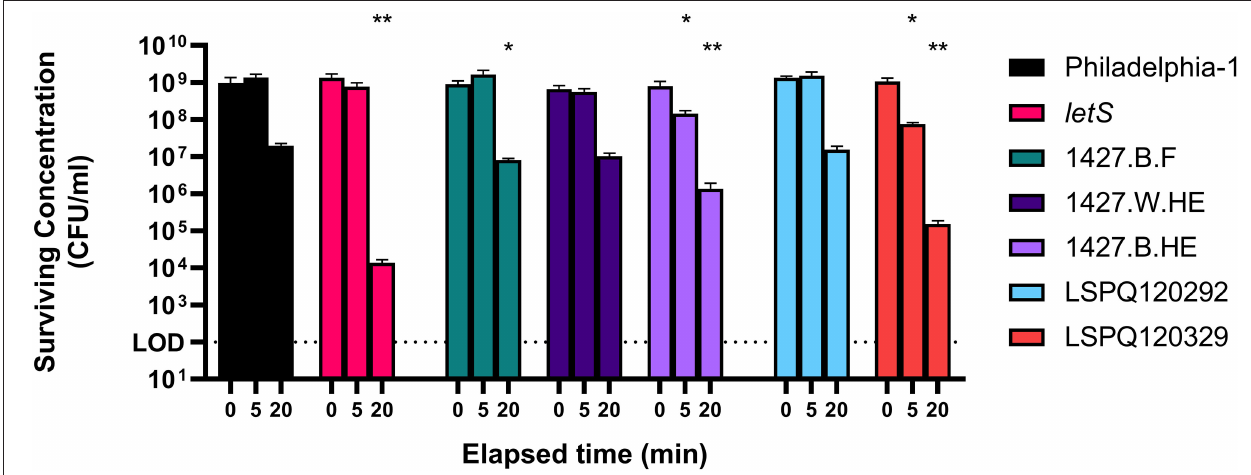
FIGURE 1 | Survival of L. pneumophila strains at 55 ◦ C. Isolates were washed in Fraquil and acclimated for 1h and heat shocked at 55 ◦ C for 5 or 20min. Error bars indicate SD of three biological replicates. Significance is shown relative to population concentration of Philadelphia-1 after the same elapsed time and is calculated using a two tailed Student’s t statistic with log-transformed data (ns = not significant, * < 0.05, ** < 0.01 with Bonferroni’s correction for 7 comparisons).